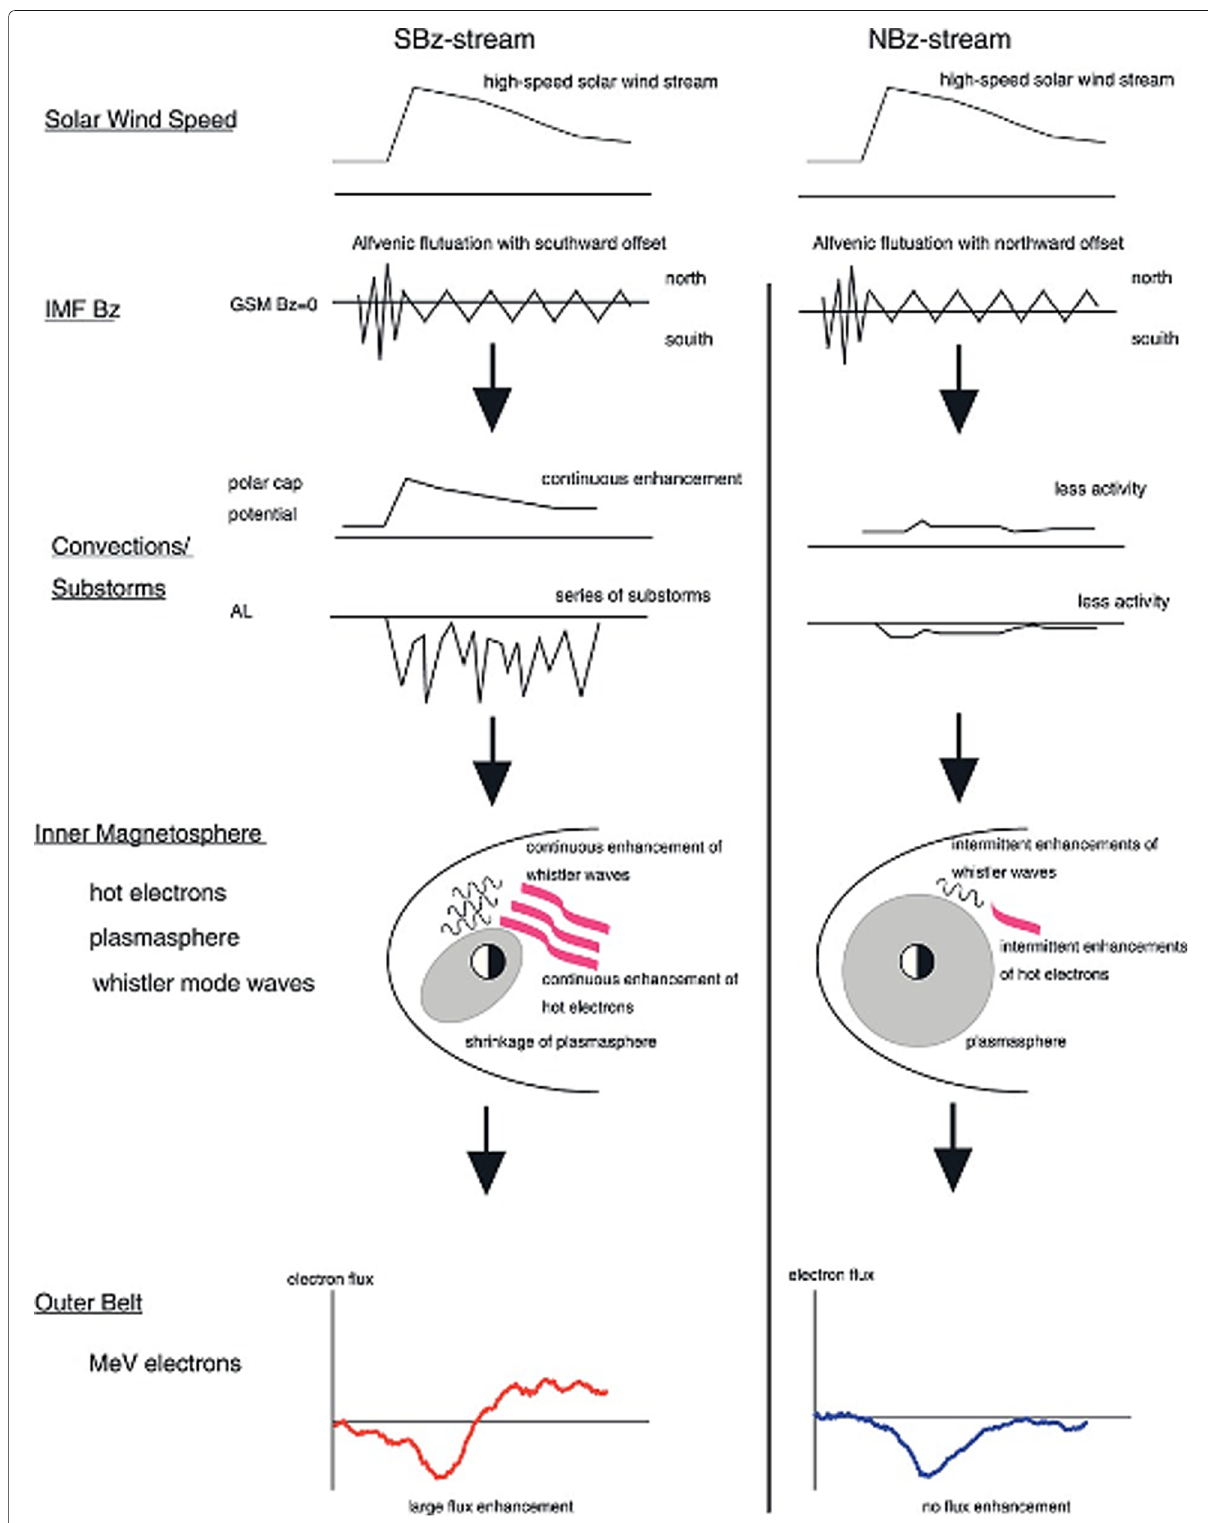
Fig. 13 Schematic of the ideal setup and sequence for strong enhancement of outer belt electrons through chorus wave-particle interactions in the high-speed streams (Miyoshi et al.